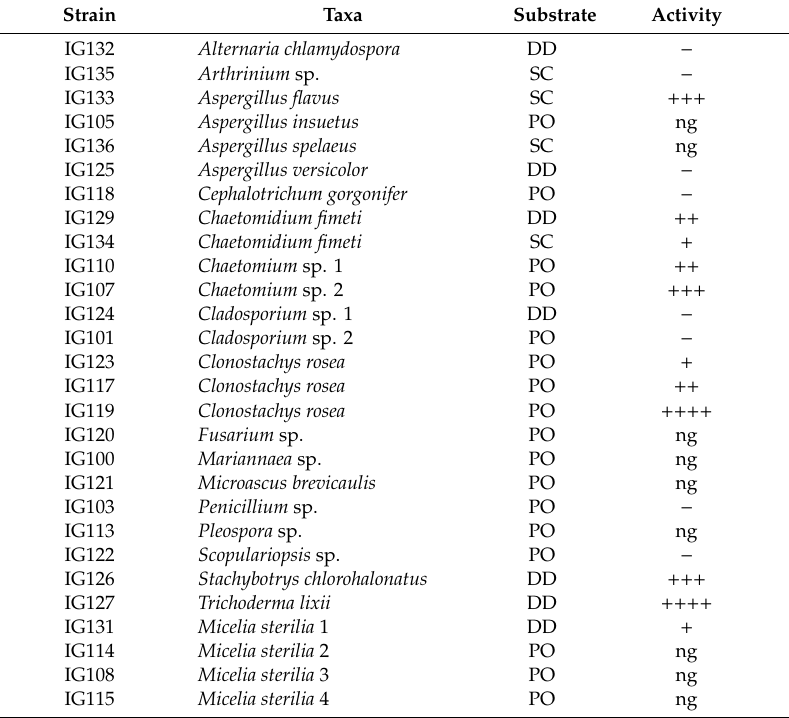
Table 1. Taxonomical a ffi liation and chitinolytic enzyme activity of the various fungal strains isolated from di ff erent marine